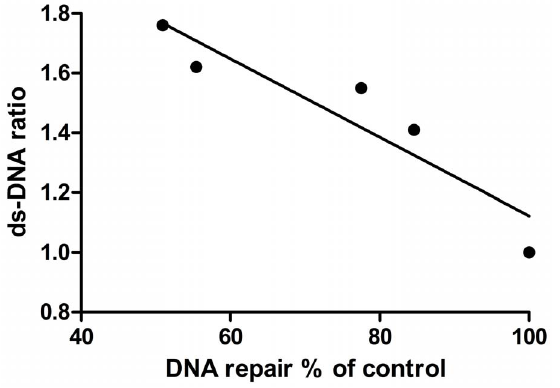
Figure 5. Correlation between ds-DNA ratio (control=1.00) and DNA repair (% of control) in H 2 O 2 -stimulated PBMC, at concentrations of 0, 0.3, 0.6, 1 and 2% v / v RBC hemolysate. For each point, N=8. Coefficient r= 2 0.925, p , 0.025. Regression line: y= 2 0.131x + 2.432.